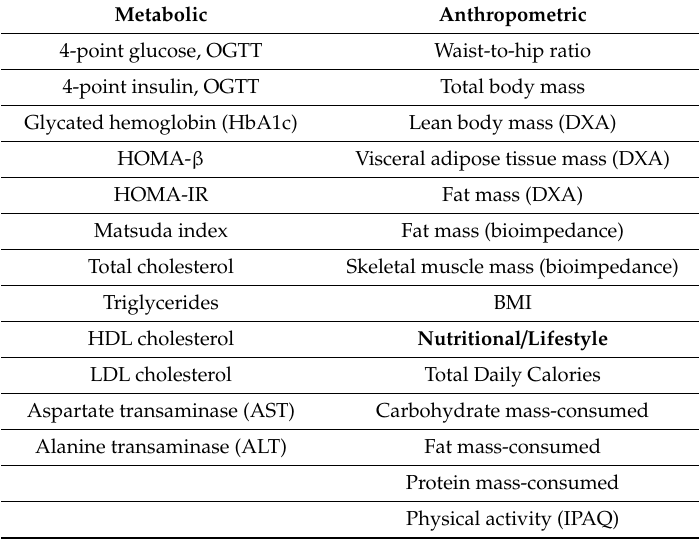
Table 1. Measurements gathered in this study divided into metabolic, anthropometric, and nutritional